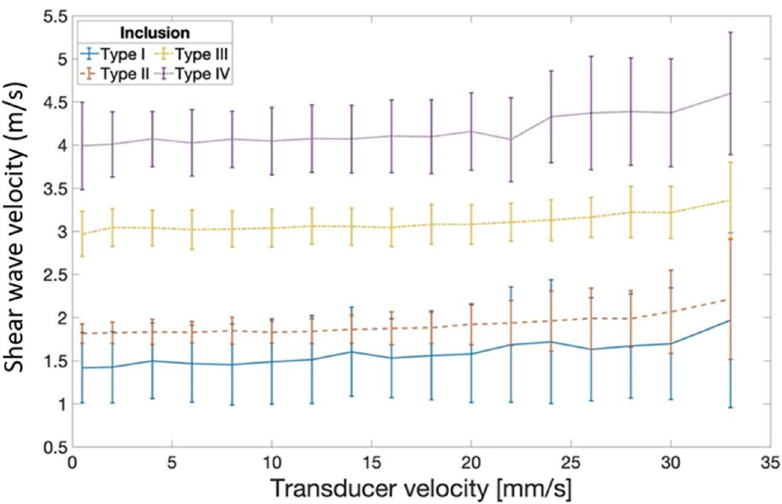
Figure 4. Mean shear wave velocity estimates based on 3D SWVM as a function of the speed of out-of-plane transducer motion during measurement. Estimates remain relatively robust at transducer motion below 20 mm/s. Error bar: ±SD.